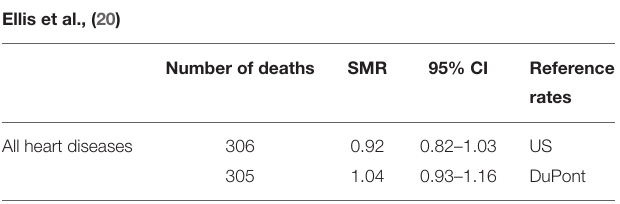
TABLE 9 | Results from extended follow–up of the DuPont cohort. Ellis et al., (20)